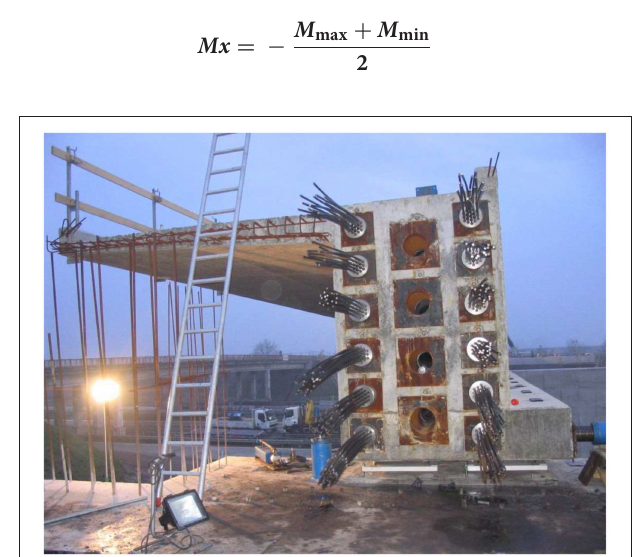
FIGURE 5 | Additional central prestress.